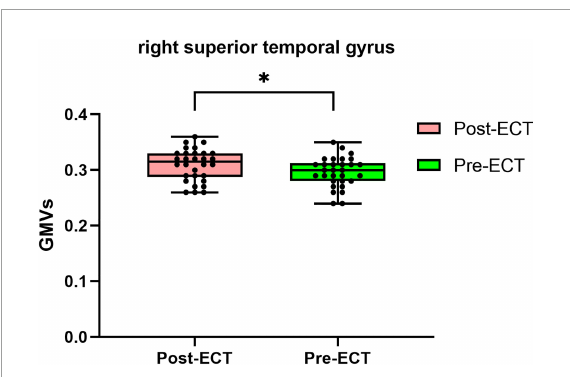
FIGURE4 Bar graph showing increased GMVs in the right superior temporal gyrus in MDDs after ECT, ∗ p < 0.05.